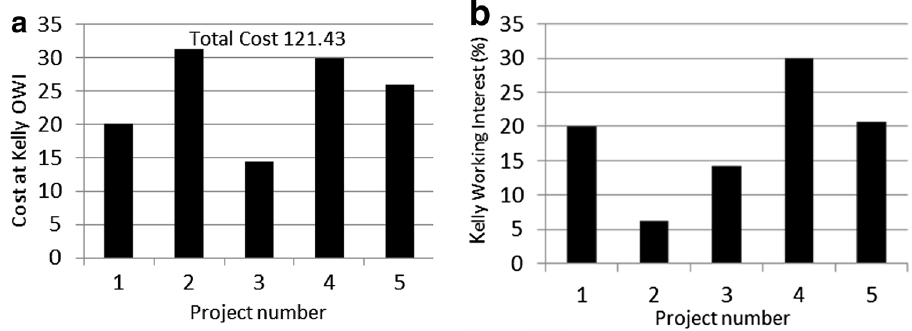
Fig. 6 a Costs per project at